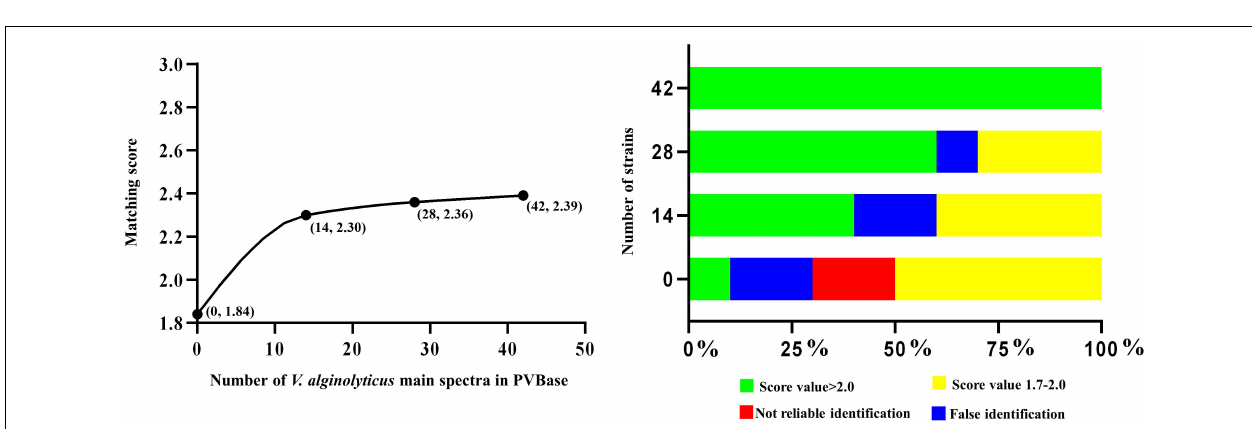
Frontiers in Microbiology |